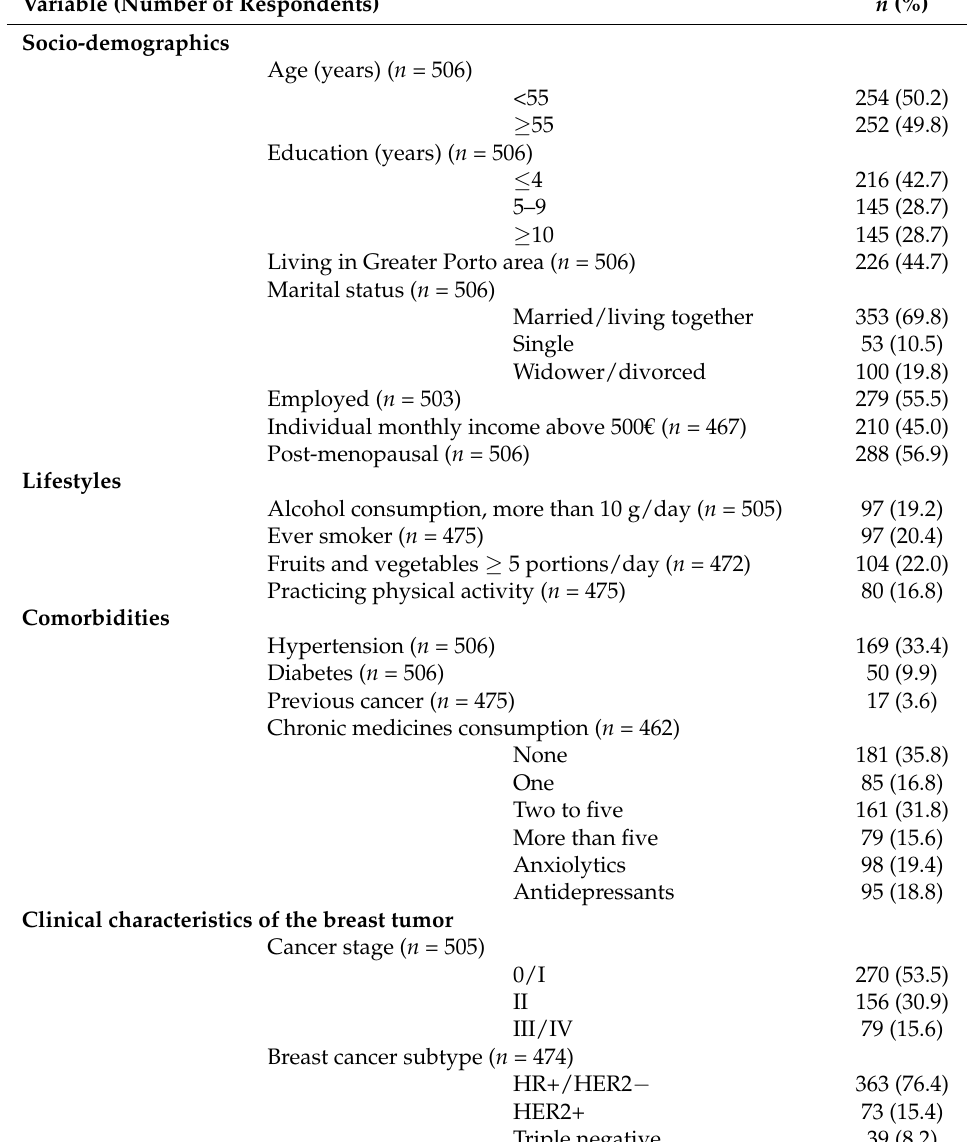
Table 1. Baseline socio-demographics characteristics of the participants, lifestyles, and comorbidities, as well as clinical characteristics of the breast